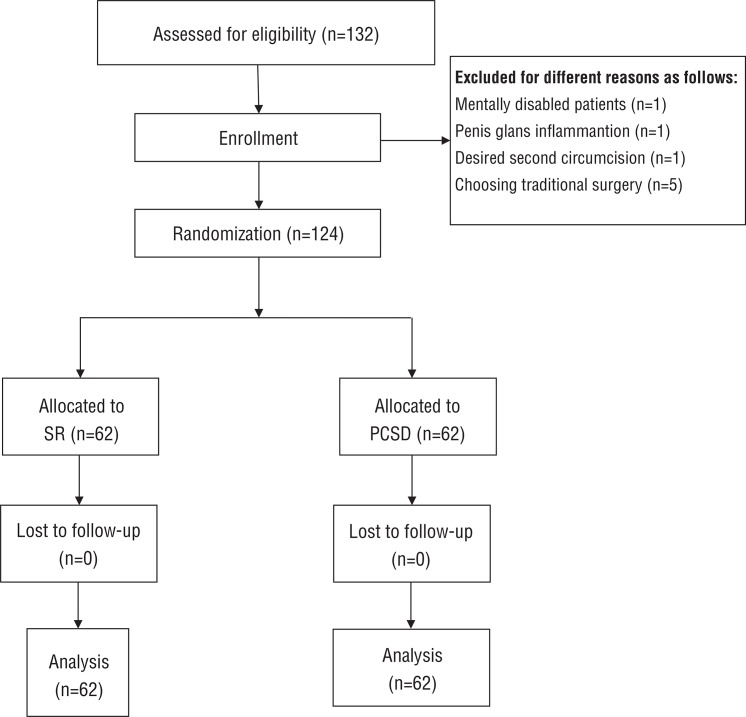
Consort diagram.